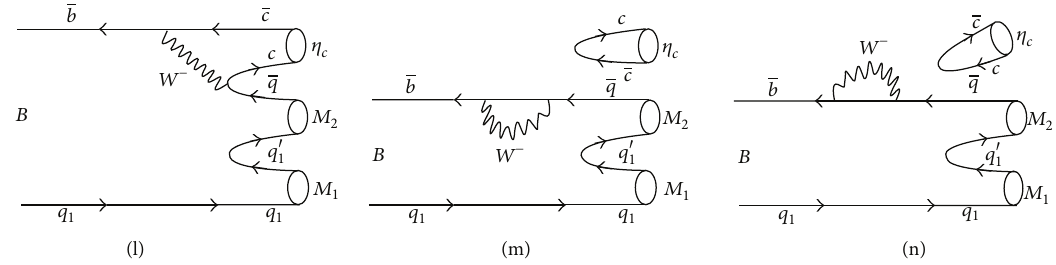
Figure 4: Quark diagrams illustrating the processes 𝐵(𝐵 𝑠 ) → 𝜂 𝑐 𝜋𝐾 ∗ decay.